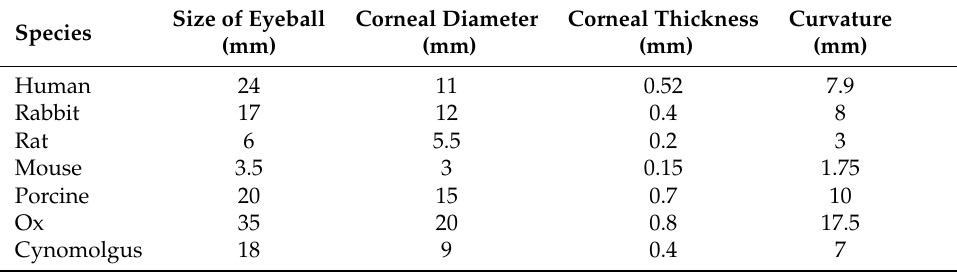
Table 1. Average dimensions of the cornea in different species